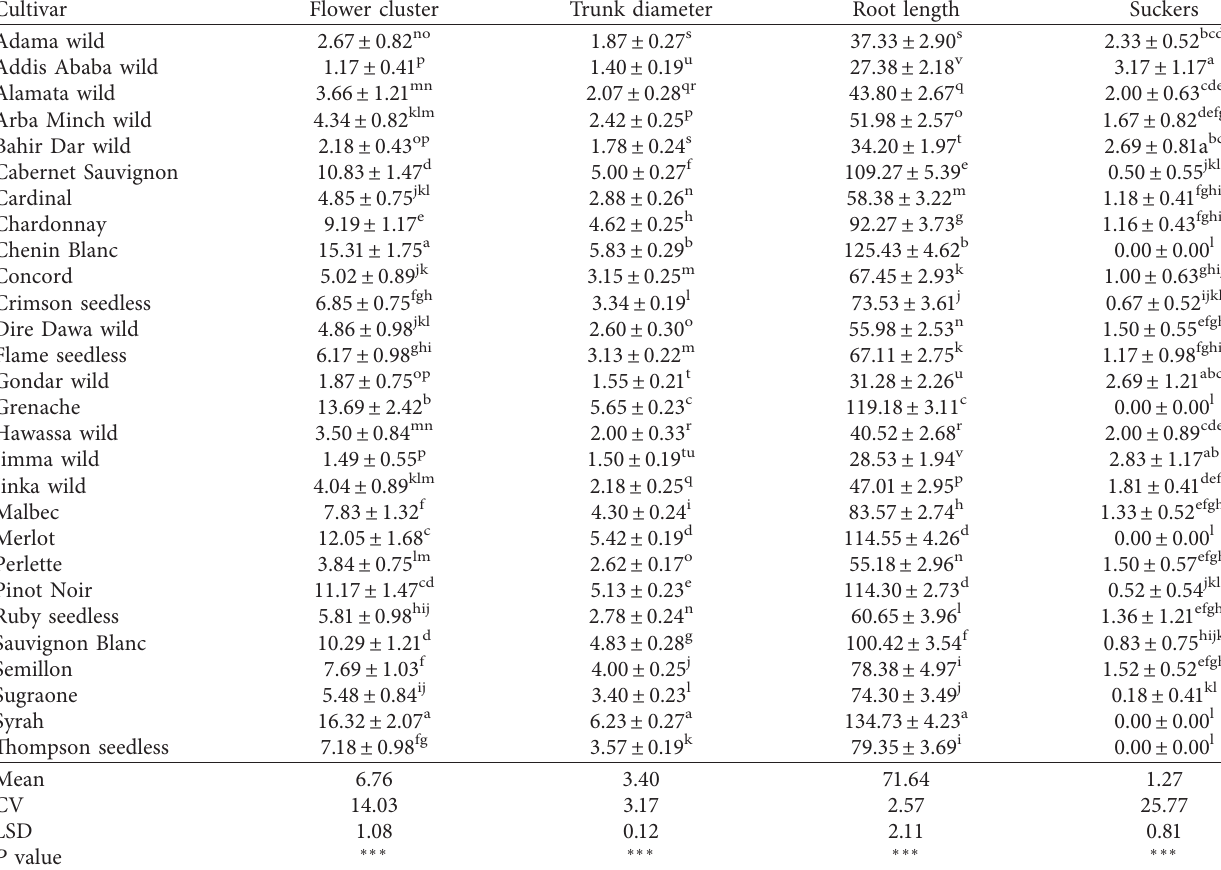
Table 2: The main effect of cultivars on grapevine trunk diameter, root length, flower number, and number of suckers per plant. Cultivar Flower cluster